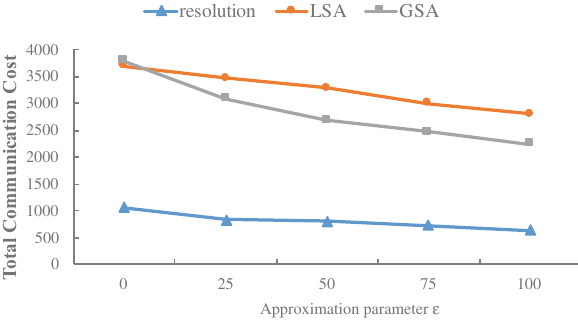
Fig. 7 Varying size of top- k set k using real dataset, w ¼ 10s, m ¼